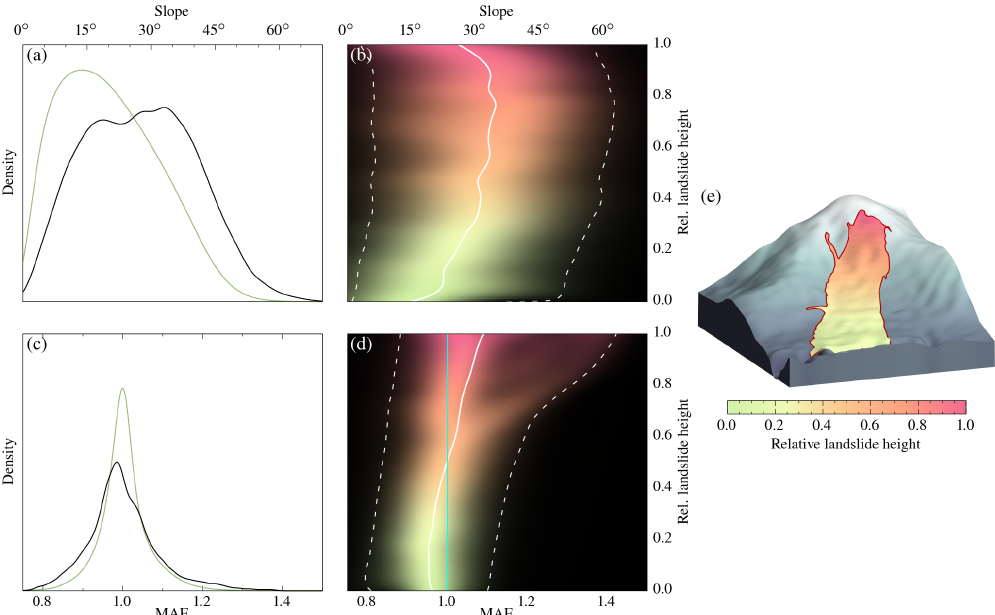
Figure 4. Distribution of hillslope inclination and MAF. The left column shows (a) hillslope inclinations and (c) MAF within the landslide- affected area (green) and within the landslide areas (black). The right column presents (b) hillslope inclinations and (d) MAF in different segments of the landslide areas which is expressed as relative height. Segments towards to the toe (relative height 0.0–0.5) are in green, and segments towards the crown are in red (relative height 0.5–1). The solid line is the mean, and the dashed lines enclose the 95% uncer- tainty range. The concept of relative height is illustrated for the Aso Ohashi landslide in (e) . MAF < 1 indicates attenuation and MAF > 1 amplification of seismic waves due to topography. The cyan line in (d) highlights MAF = 1, i.e. no amplification or